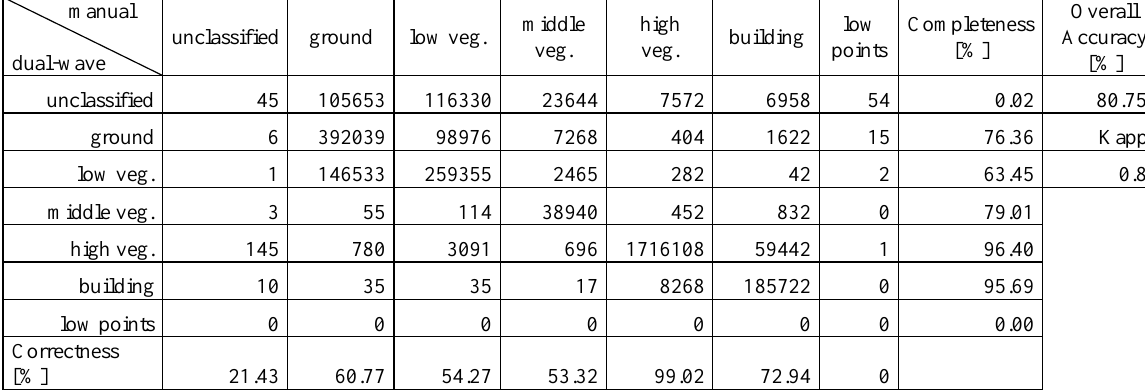
Table 1 Confusion matrix and accuracy estimates for the dual-wavelength classification manual dual-wave